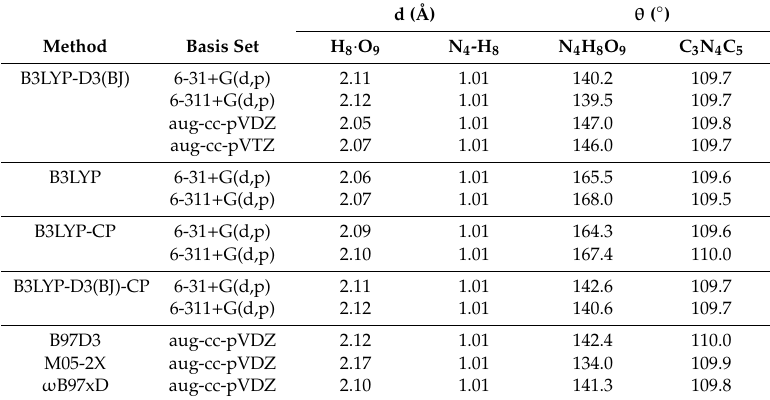
Table 1. Structural parameters from the equilibrium geometries of 1Py-CH using several B3LYP methods and basis sets in the gas phase against several high-level density functional theory (DFT) methods with an aug-cc-pVDZ basis set.